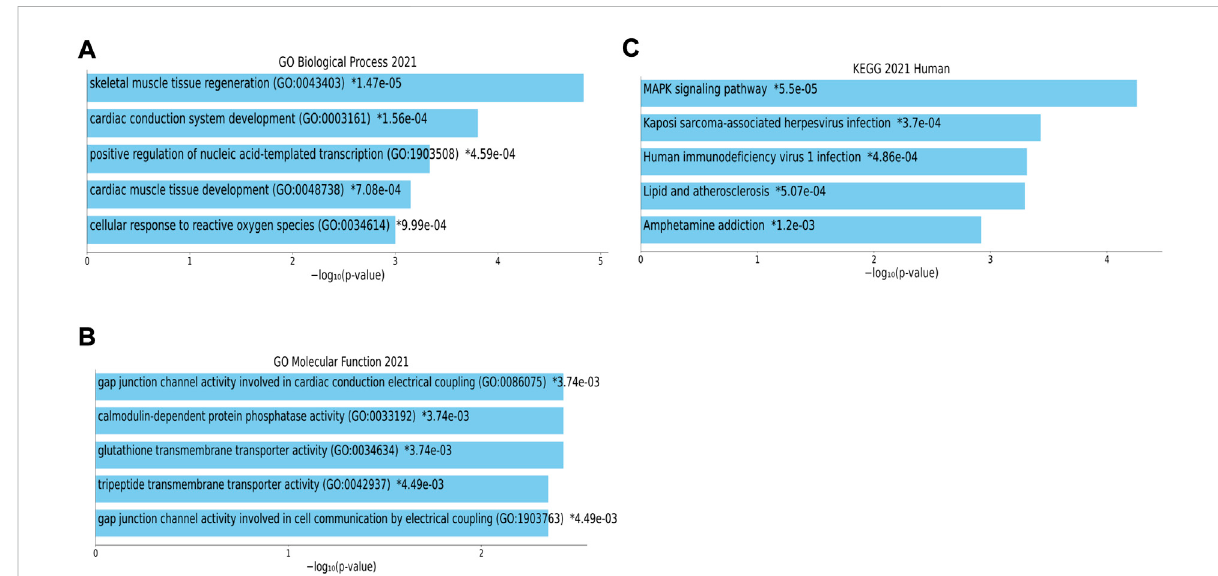
FIGURE 5 Biologicalprocess(BP), molecularfunction(MF)andKyotoEncyclopediaofGenesandGenomes(KEGG)pathway enrichmentanalysis.Thetop fi ve enriched terms of (A) BP, (B) MF, and (C) KEGG are displayed along with the corresponding p -values in a bar graph. Those with signi fi cant p -values (i.e., < 0.05) are matched with the colored bars. A p -value (shown with *) shows the signi fi cant adjusted p -value ( < 0.05).